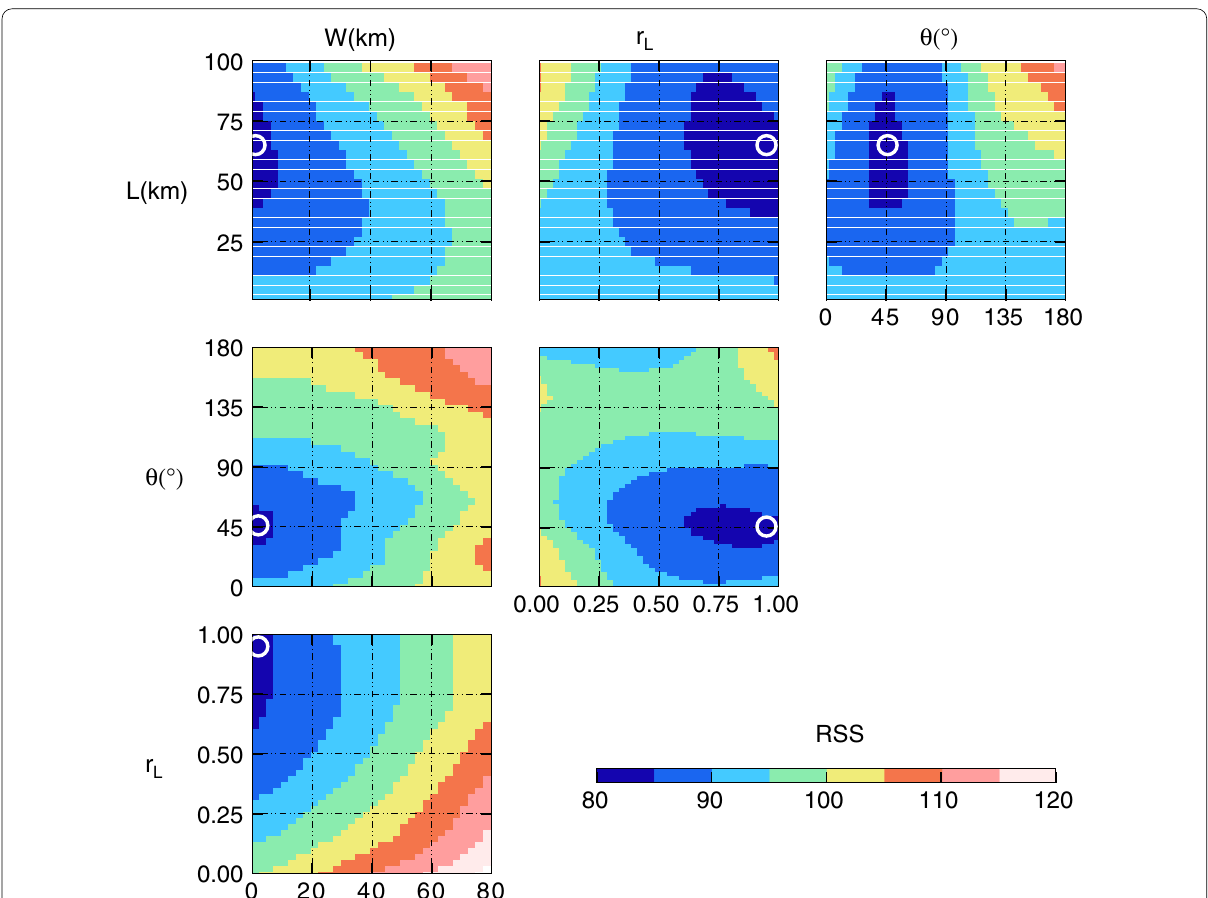
Fig. 16 Residual surface of the four model parameters ( L , W , θ , and r L ) at 100 s after the origin time for the 2016 Kumamoto earthquake. The format is the same as Fig.